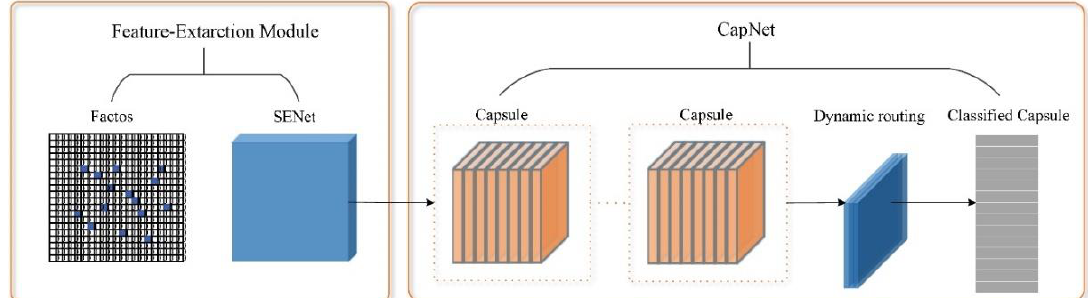
Figure 6. The framework of SE-CapNet.